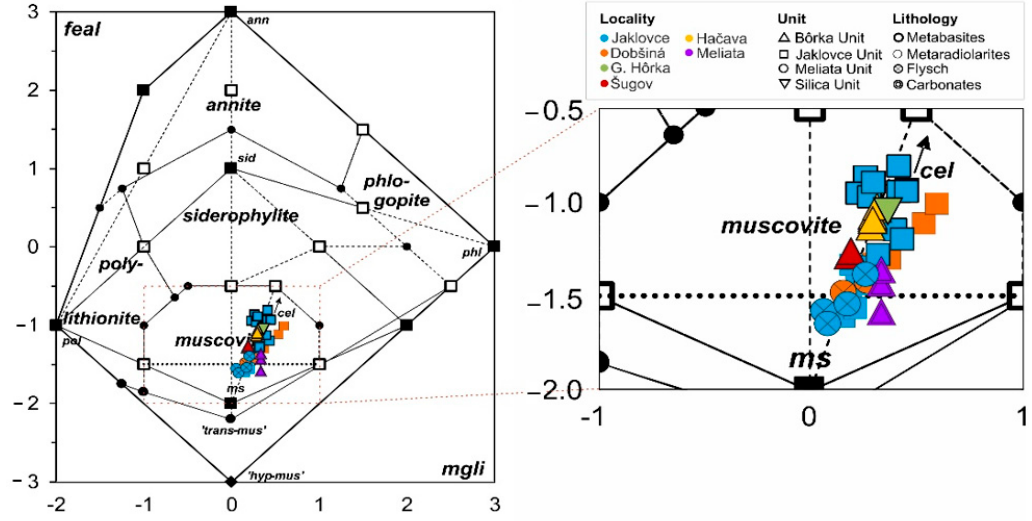
Figure 21. Classification diagram of white mica from the B ô rka, Jaklovce, Meliata and Silica units as